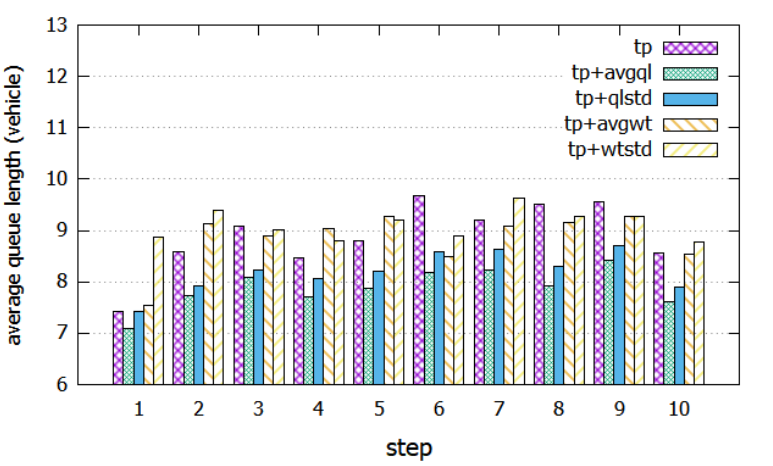
Figure 1. Performance of a technique for determining the phase order in terms of the average queue length.